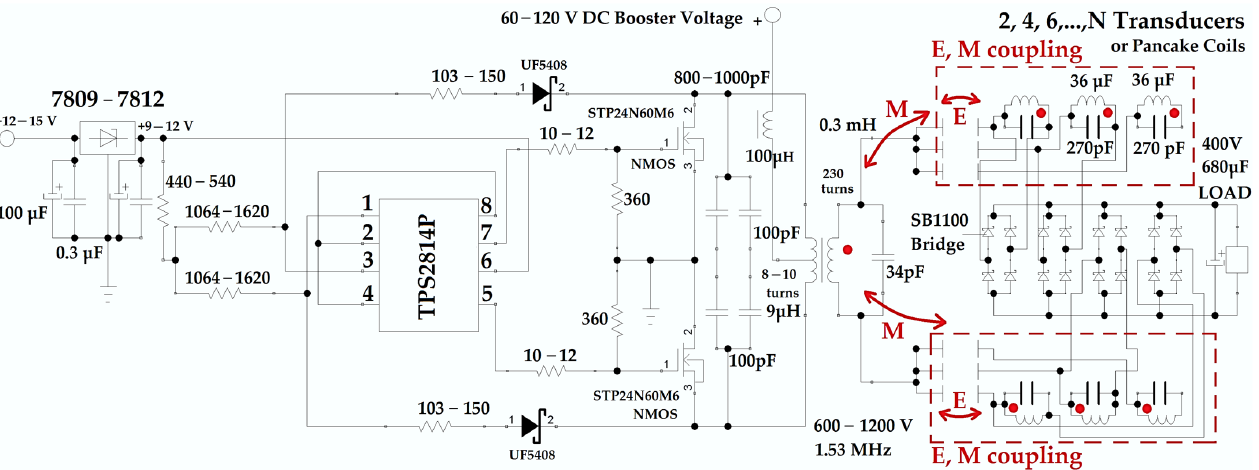
Figure 5. Photograph of the wireless power system for the C3 configuration, pancake coils at 30 mm distance ( top ), schematic of the system with a TPS2814P gate driver, a Royer circuit with ZVS, a resonant air transformer and two, four or more double-sided pancake coil transducers ( bottom ), where E is the coupling electric field and M is the coupling magnetic field (or mutual inductance). Table 3. Measured transducer current and voltage at different distances and configurations.